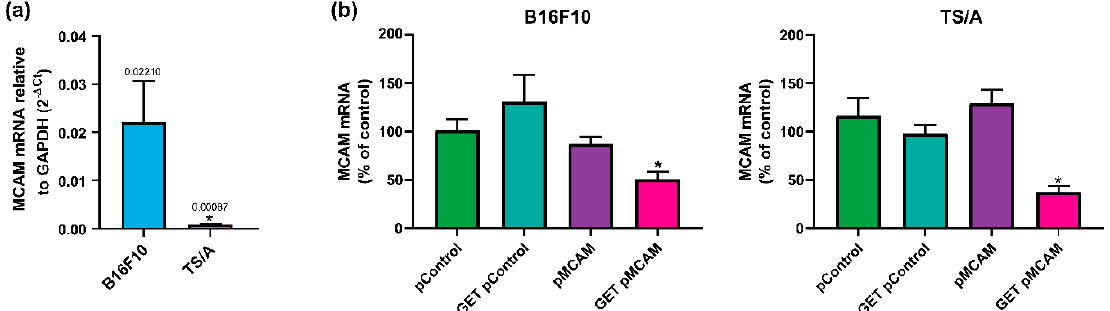
Figure 2. In vitro expression of MCAM mRNA level in untreated B16F10 melanoma and TS/A carcinoma cells ( a ) and reduced expression of MCAM mRNA level after silencing using gene electrotransfer (GET) in B16F10 melanoma and TS/A carcinoma cells ( b ) determined by qPCR analysis. ( a ) The data represent the mean and standard error of the mean ( n = 4). The mRNA levels of MCAM in tumors were normalized to the mRNA level of the glyceraldehyde 3-phosphate dehydrogenase (GAPDH). * p < 0.05 compared to B16F10 melanoma. ( b ) The data represent the mean and standard error of the mean ( n = 5). The mRNA levels of MCAM in cells of all experimental groups were normalized to the mRNA level of the untreated group. pMCAM: plasmid-encoding short hairpin RNA (shRNA) against melanoma cell adhesion molecule; pControl: control plasmid; * p < 0.05 compared to all other